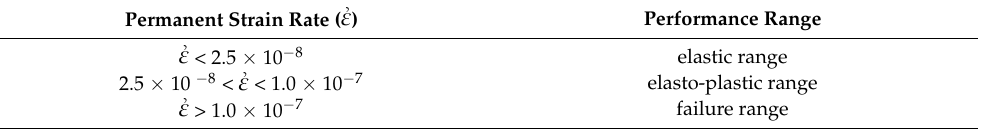
Table 3. Classification of the deformation behaviour according to Coulomb model where 𝑎 is the apparent attraction considered equal to 20 kPa [45]. Permanent Strain Rate ( ἐ )